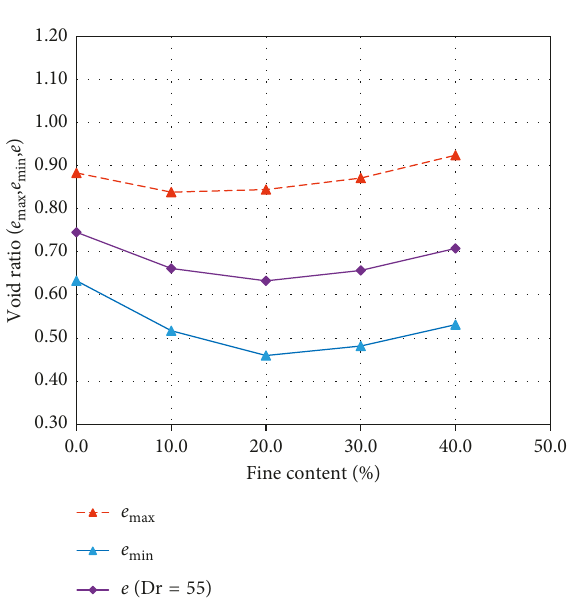
Figure 2: Void ratio curve for the prepared samples.